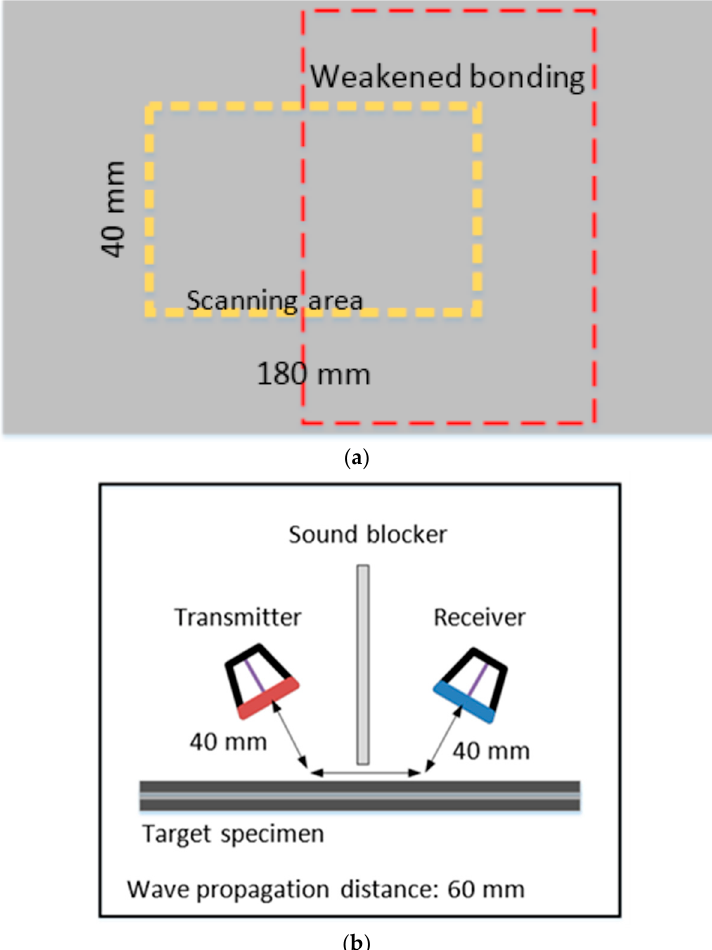
Figure 12. ( a ) Schematic view of the dimensions of the scanning area and location of weakened bonding damage; ( b ) A schematic illustration of the pitch-catch configuration area for weakened bonding detection in the adhesive bonded triplex.